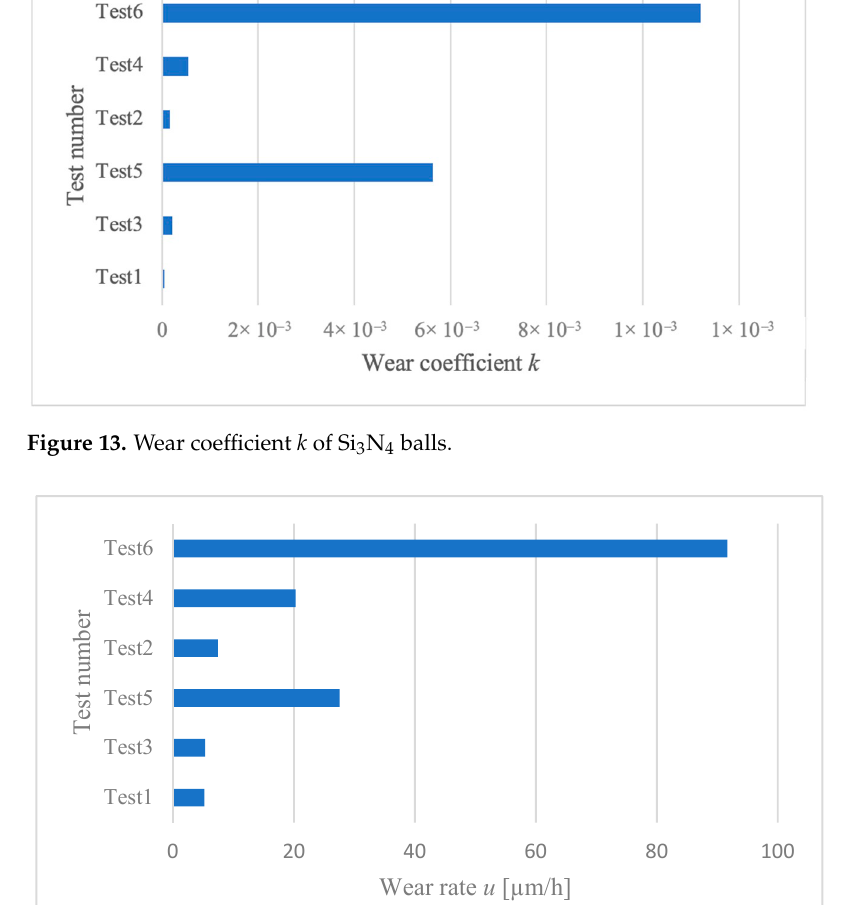
Figure 14. Wear rate u of Si 3 N 4 balls.